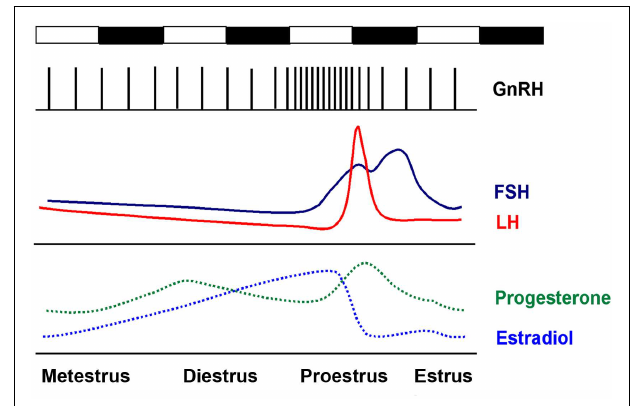
FIGURE 1 |The rodent estrous cycle . In the mouse, ovulation occurs every 4–5days. Metestrus and diestrus are characterized by low but slowly increasing levels of estradiol. On the late afternoon of proestrus, elevated estradiol levels induce a bolus of GnRH release from the hypothalamus, which induces the proestrus LH and FSH surge at approximately the start of the active (dark) period. Ovulation occurs 12–14h later.